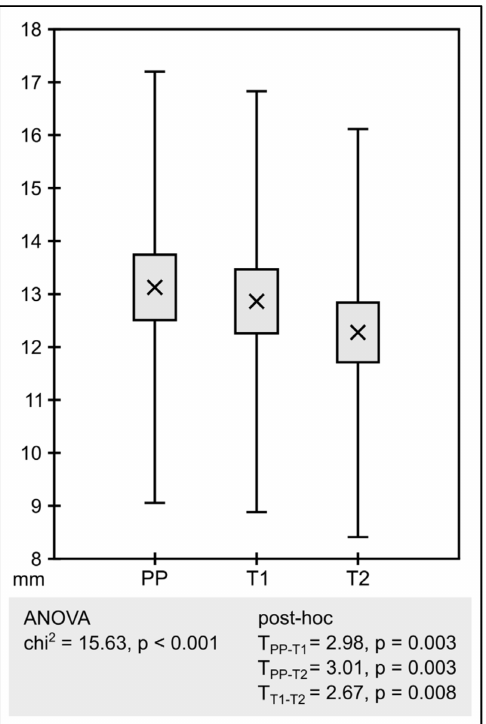
Figure 2. Analysis of inhibition zone diameters (PP—pure powder, T1—tablet 1, T2—tablet 2). The graph compares the mean of the determinations. The boxes show standard error and the whiskers shows standard deviation.